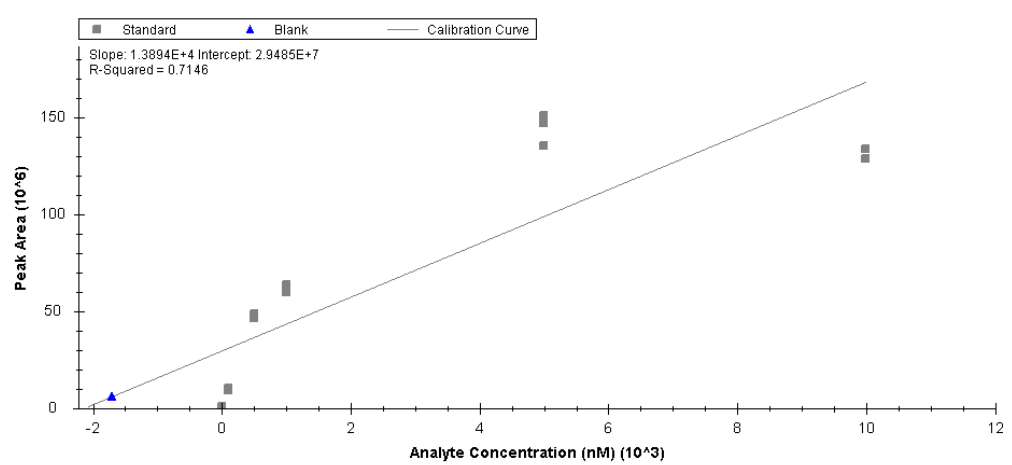
Figure A1. Triglycerides ( TG) 54:6 label-free quantification using external calibration (n = 3).